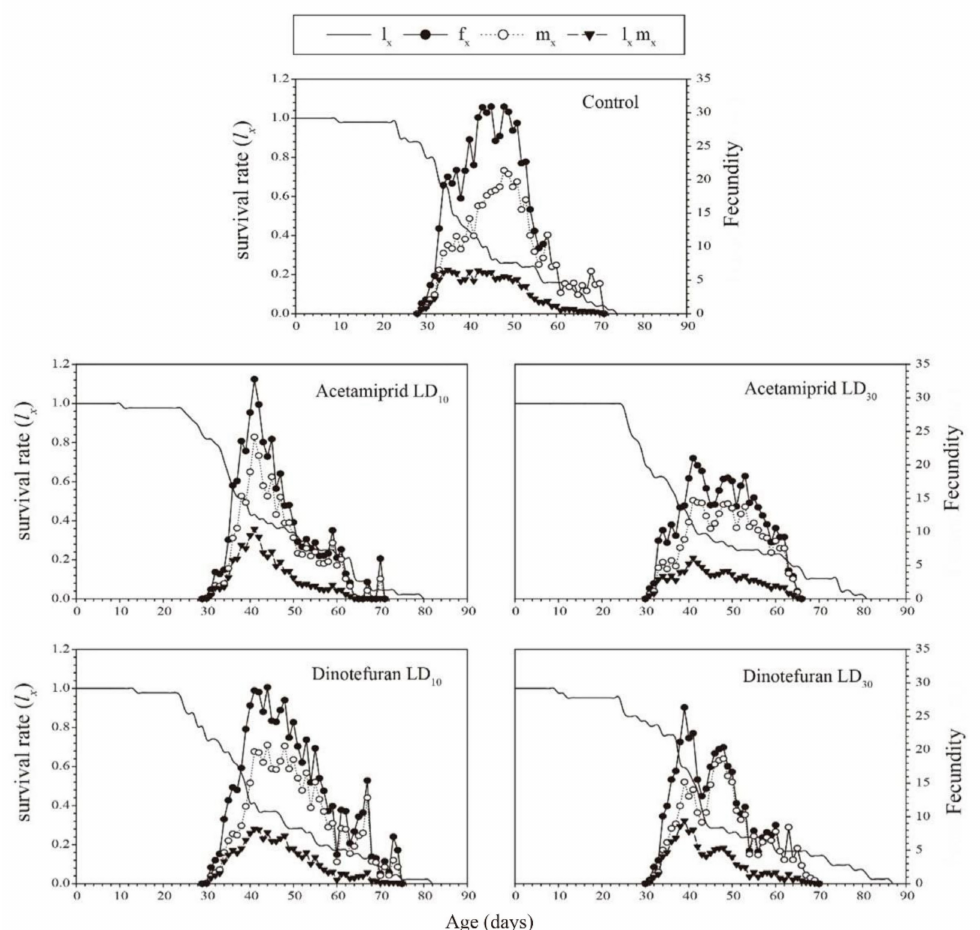
Figure 2. Age-specific survival rate ( l x ), female age-specific fecundity ( f x ), age-specific fecundity ( m x ), and age-specific maternity ( l x m x ) for 2nd instar C. pallens larvae exposed to sublethal acetamiprid and dinotefuran